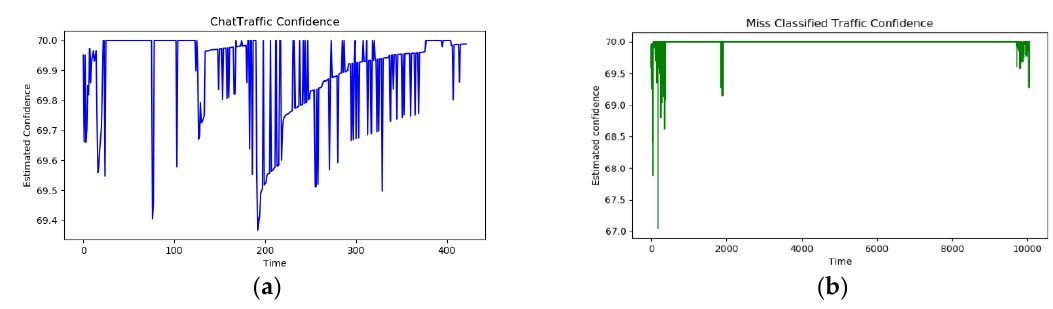
Figure 11. Confidence value trend of packets whose membership level is the maximum for chat type among all data. ( a ) shows the distribution of the actual chat type data. ( b ) shows the distribution of the misclassified data.